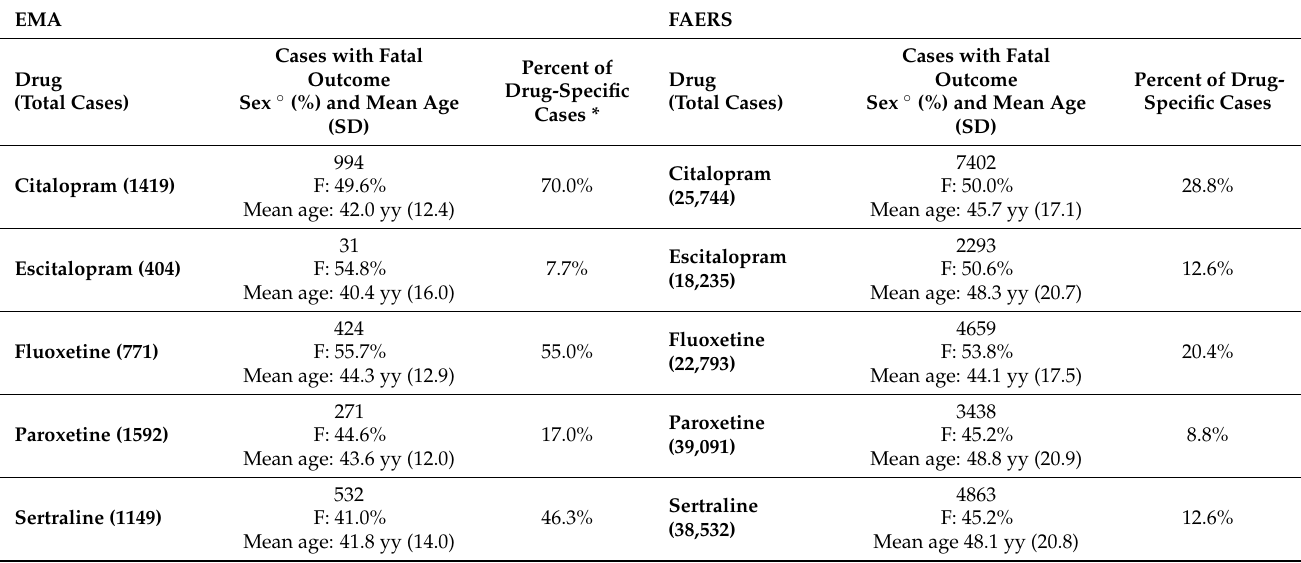
Table 2. Outcome of selective serotonin reuptake inhibitor (SSRI)-related adverse drug reactions reported to the European Medicines Agency (EMA) EudraVigilance (EV) dataset and the Food and Drug Administration (FDA) Adverse Event Reporting